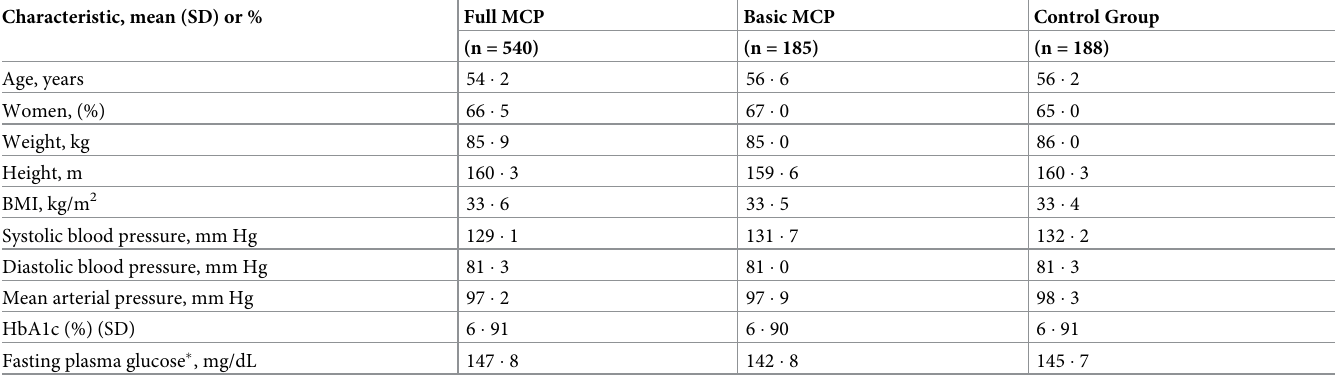
Table 1. Baseline participant